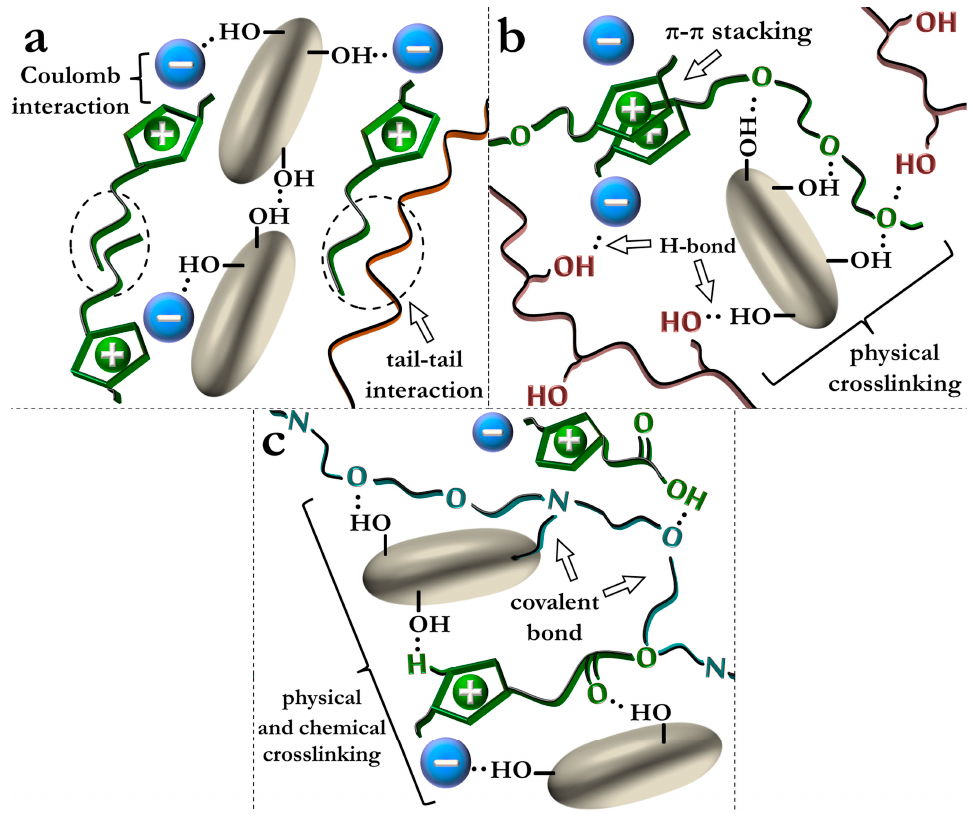
Figure 7. Representation types of interfacial interactions among silica-IL and ( a ) nonpolar (e.g., polyolefins) and polar ( b ) PVOH and ( c ) epoxy